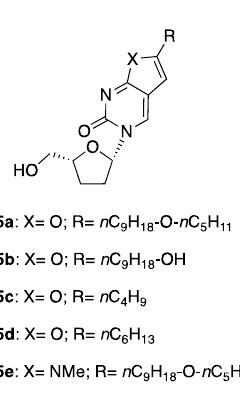
Figure 2. Chemical structures of nucleoside analogues 5a – 5e . These molecules are currently being investigated in our group for their potential antiviral activity against different flaviviruses ; the scaffold of 5a has been previously reported for its indirect antiviral properties against vaccinia and measles viruses.